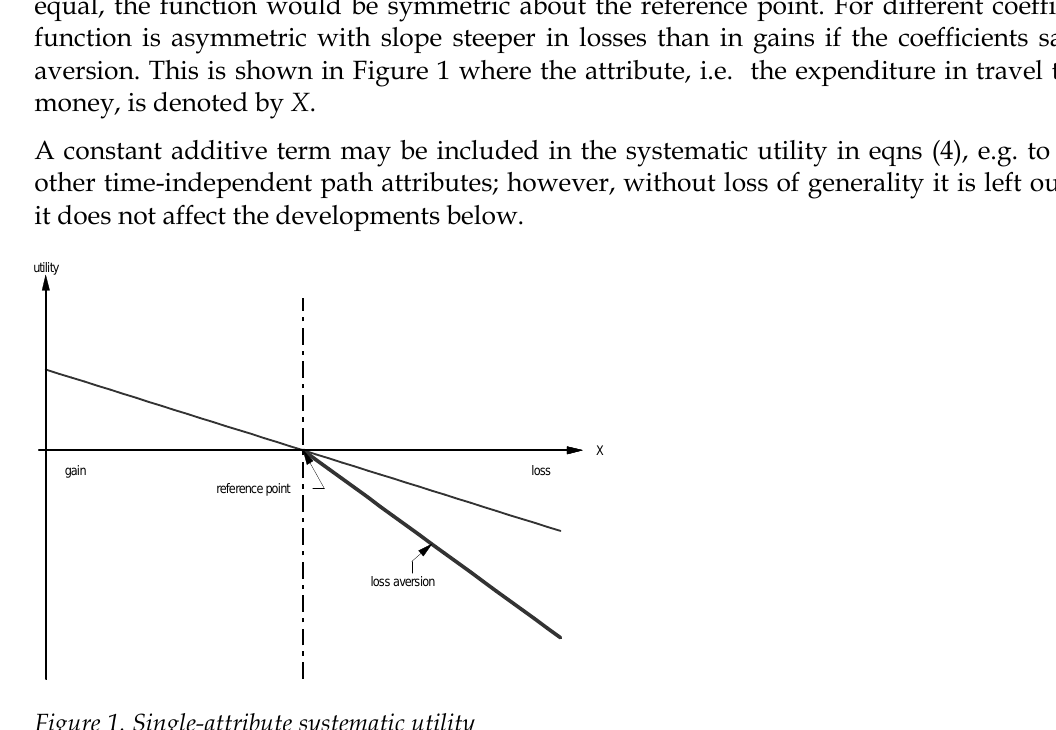
Figure 1. Single-attribute systematic